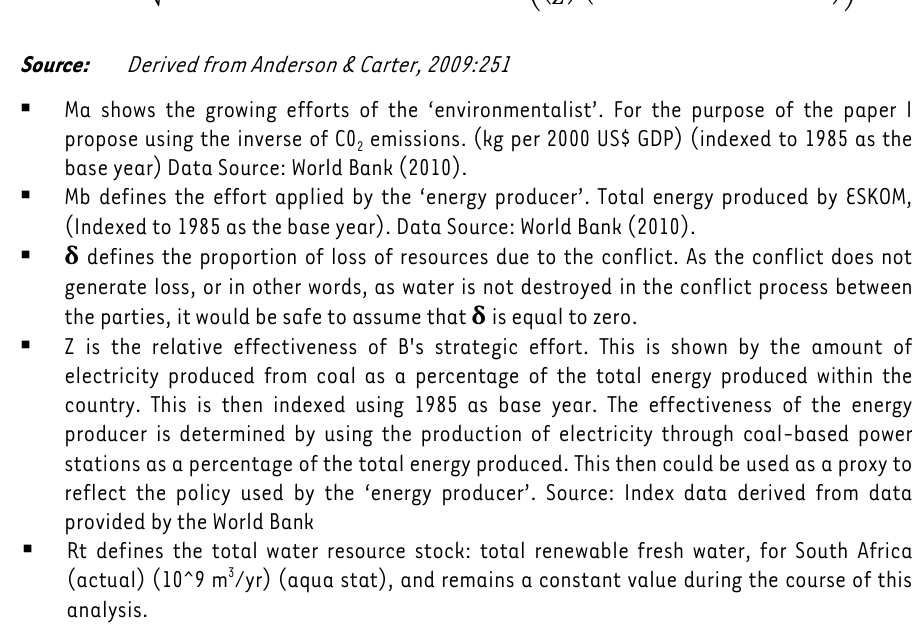
TABLE 3: Data used in the analysis of the reaction